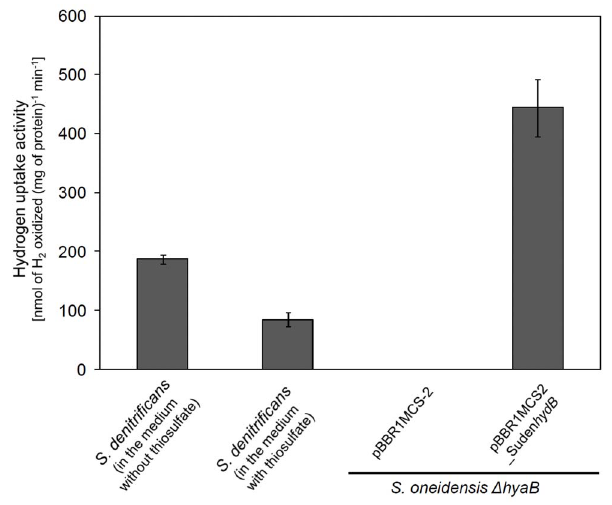
Figure 5. Hydrogen uptake activity of the native and recom- binant hydrogenase (HydB) from S. denitrificans . Hydrogen uptake activity was measured in the membrane fractions of S. denitrificans grown without and with thiosulfate (18.8 mM) and for the recombinant version of the large subunit (HydB). The large subunit of the periplasmic hydrogenase ( hydB ) was cloned into the vector pBBR1MCS-2 and expressed heterologously in S. oneidensis D hyaB . The empty vector in S. oneidensis D hyaB was used as negative control. Error bars denote standard deviations from three independent